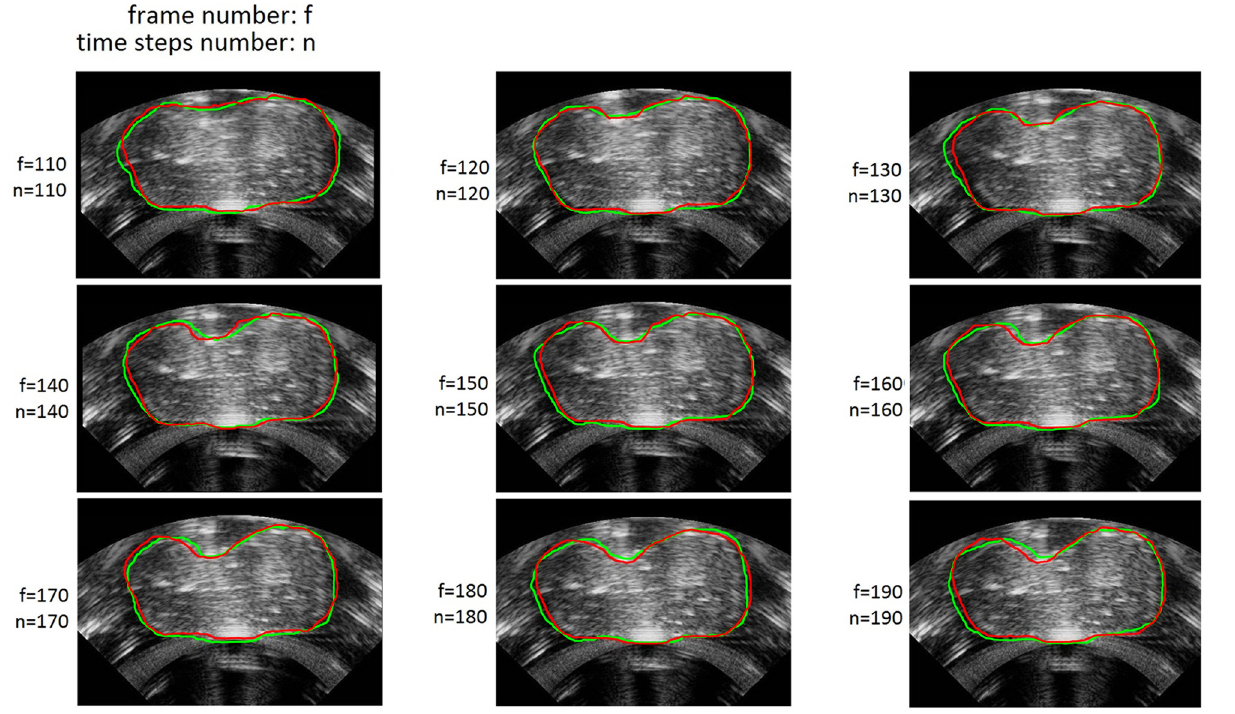
Fig 4. Comparison of ground truth contours (green contour) with the corresponding predicted contours (red contour). The figures are from the validation set. The results illustrate that the predicted contours are very close to the ground truth contours, indicating the effectiveness of our